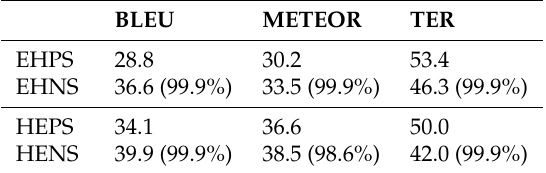
Table 2. Performance of PB-SMT and NMT systems on automatic evaluation metrics. EHPS, English-to-Hindi system; EHNS, English-to-Hindi system; HEPS, Hindi-to-English PB-SMT system; HENS, Hindi-to-English NMT system.